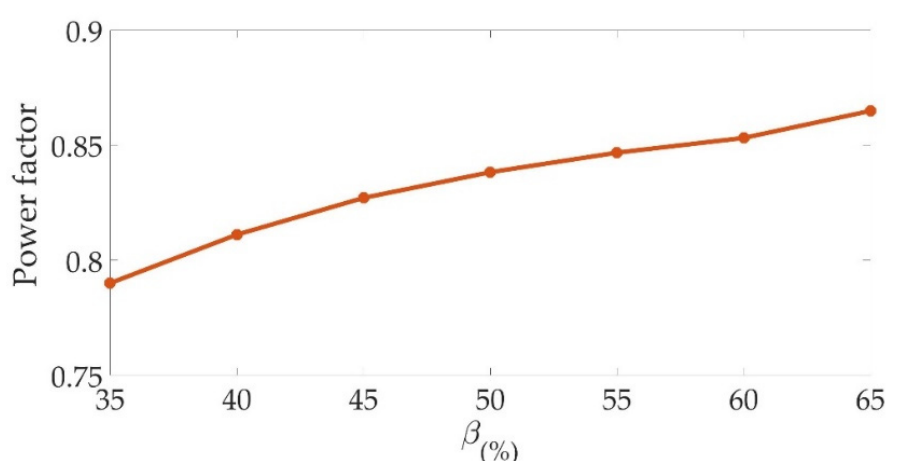
Figure 16. Power factor with different ratios β ( α = 0%).